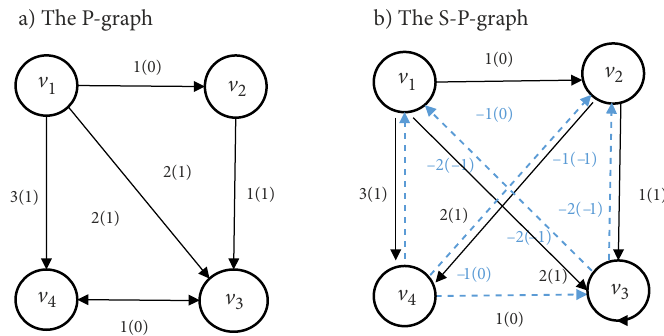
Figure 1. The P-graph and S-P-graph of the special NPLPR B (sources: authors’ own